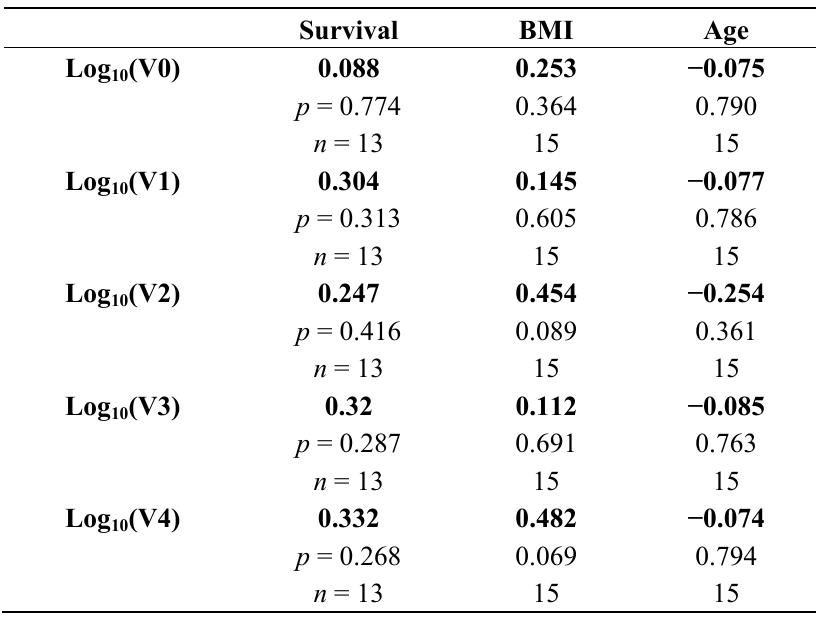
Table 6. Correlation of HE4 variants expression levels with Serous EC patients’ clinical data. In serous cancer group, there was no significant correlation between the variants expression and patients’ survival, BMI and Age.